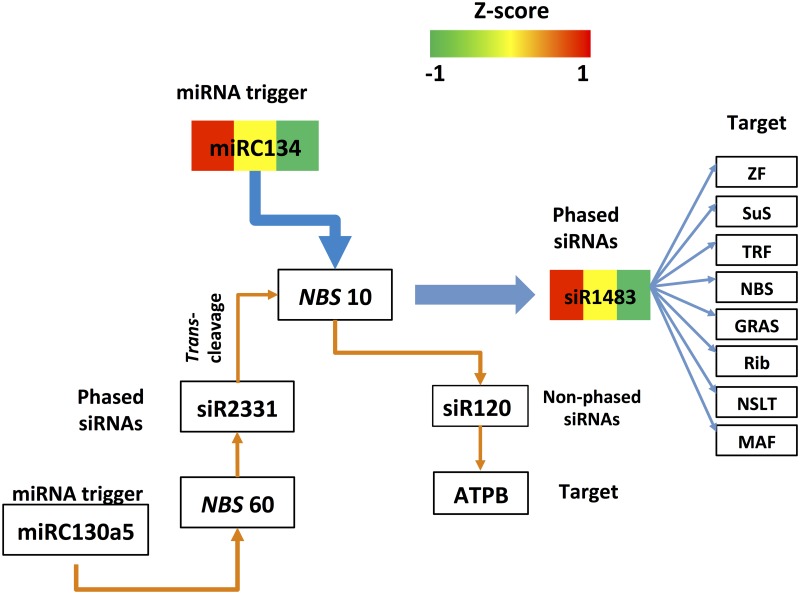
A pha-siRNA regulatory pathway that is co-regulated by miRC134 and pha-siR2331.The pathway of pha-siRNAs derived from NBS 10 that is co-regulated by miRC134 and phased siRNAs, siR2331, is shown as indicated. The blue arrows and lines show the regulatory pathway of pha-siRNAs produced from NBS 10, while the dark orange arrows and lines show the regulatory pathway of trans-cleavage by pha-siRNA, siR2331, which is derived from NBS 60. The colors in the boxes from left to right represent the Z-score of expression values of sRNAs in the leaf, flower and boll, respectively, while miRC130a5, siR2331, and siR120, are not differentially expressed in the tissues exampled. NBS 10 or 60: NBS-LRR disease resistance protein 10 or 60; ZF: Zinc finger protein; SuS: sucrose synthase; TRF: Transducin-related family protein; GRAS: GRAS family protein; Rib: Ribophorin 1 family protein; NSLT: Non-specific lipid-transfer protein; MAF: Mitochondrial carrier family protein; ATPB: ATP binding protein.